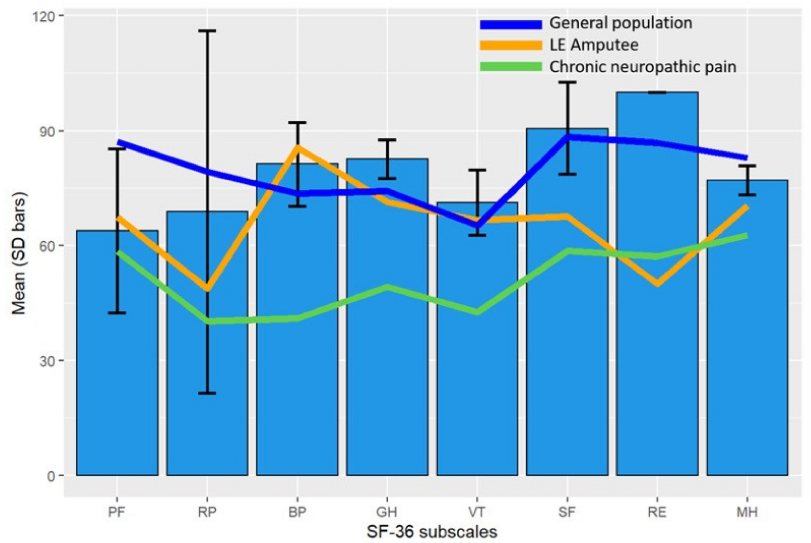
Figure 6. Comparison of mean test scores of the eight SF-36 subscales for TSR patients (blue bars) with the age-adjusted mean SF-36 scores of the general German population (navy blue line), lower extremity amputee population (orange line), and chronic neuropathic pain population (green line). Eight subscales measuring different domains of health-related quality of life: physical functioning (PF), role limitations—physical (RP), bodily pain (BP), general health (GH), vitality (VT), social functioning (SF), role limitations—emotional (RE), and mental health (MH). SD: Standard Deviation; LE: Lower